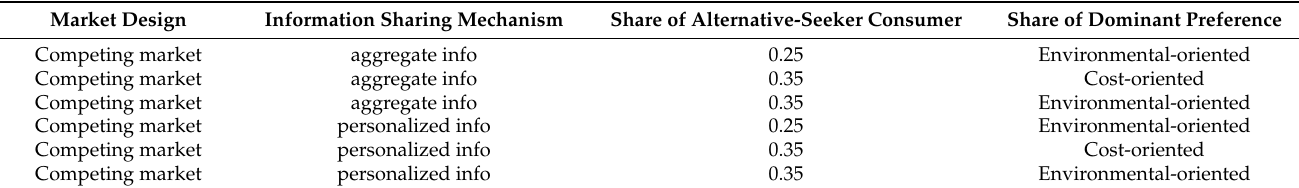
Table 4. Selected variables for scenario design.